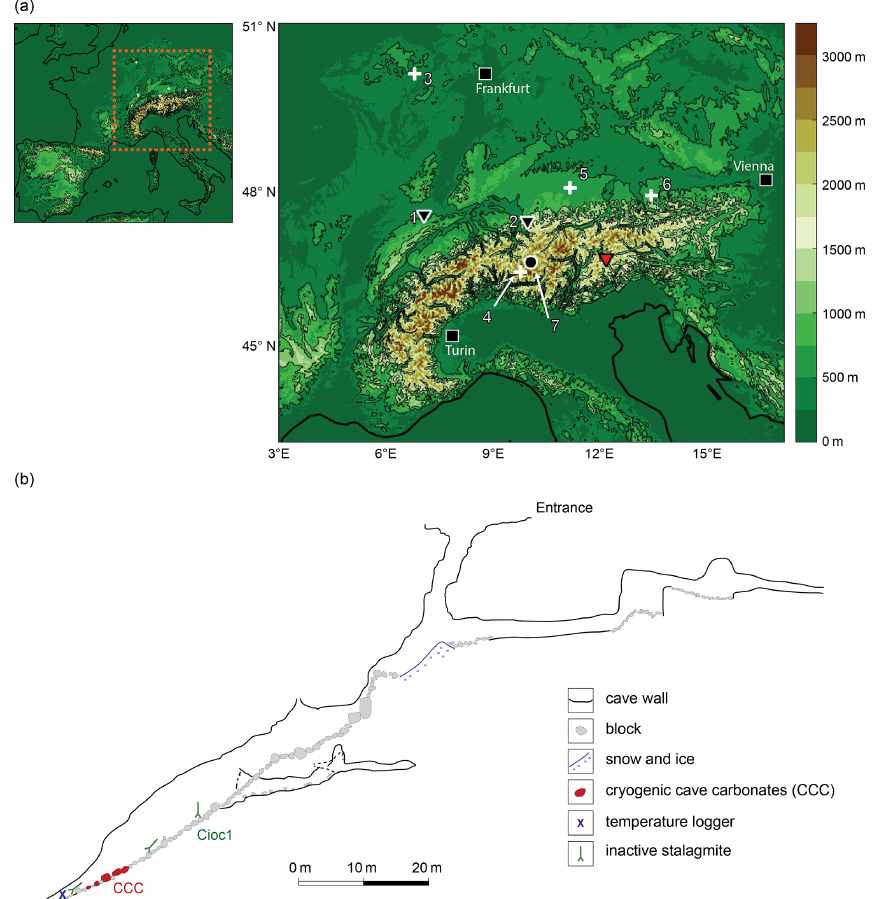
Figure 1. Relief map of Europe (upper left corner) and the Alps showing the location of Cioccherloch (red triangle) and other European YD speleothem (black triangle), lacustrine (white cross) and palaeoglacier (black circle) records (a) mentioned in the text (1 – Milandre Cave, 2 – Bärenhöhle, 3 – Meerfelder Maar, 4 – Maloja Pass, 5 – Ammersee, 6 – Mondsee, 7 – Err–Julier area). Vertical cross section of Cioccherloch Cave showing the cryogenic cave carbonate (CCC) occurrence in the terminal chamber (b)